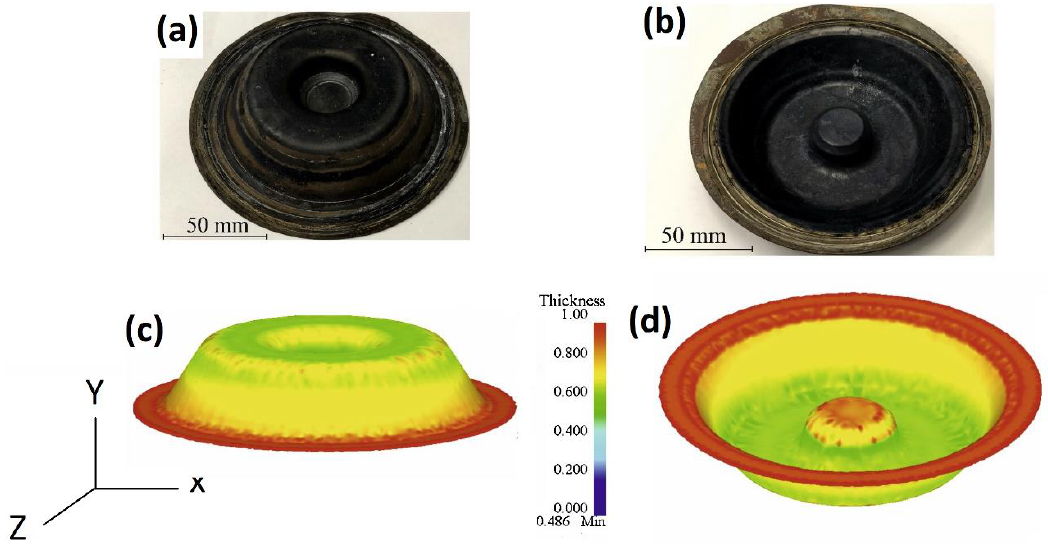
Figure 9. Comparison between experimental superplastic-forming ( a , b ) and results of FES ( c , d ) for Ti-6%Al-4%V titanium alloy [161].